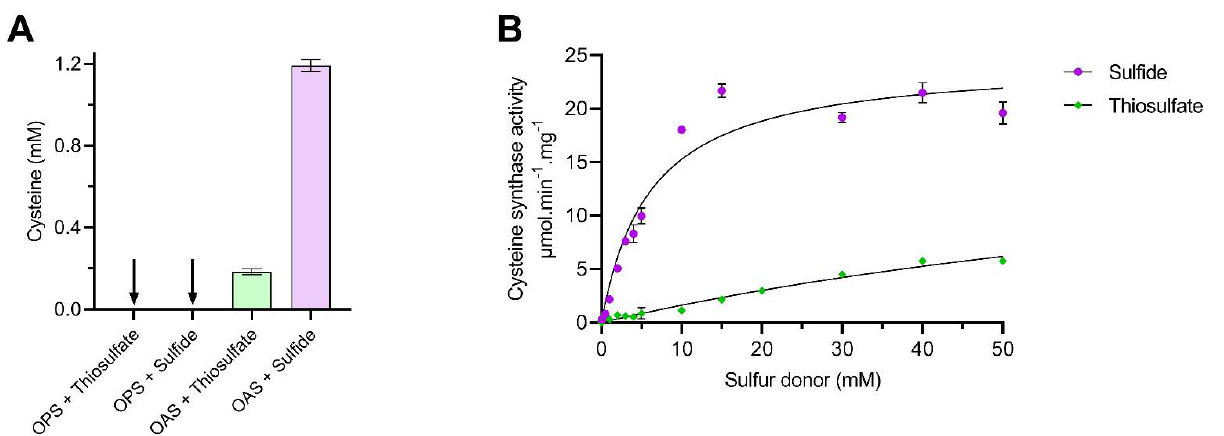
Figure 4. Cysteine synthase activity of CysM with sulfur donors thiosulfate and sulfide. ( A ) Synthesis of cysteine by CysM was followed by acid-ninhydrin assay. After 30 min, cysteine was detected for both thiosulfate and sulfide when using OAS as acceptor, but not OPS. ( B ) Michaelis-Menten kinetics for sulfide and thiosulfate when using OAS as sulfur acceptor. Sulfide: K m 6.12 ± 1.12, V max 24.60 ± 1.46. Thiosulfate: K m 118.1 ± 68.7, V max 20.80 ± 9.26.